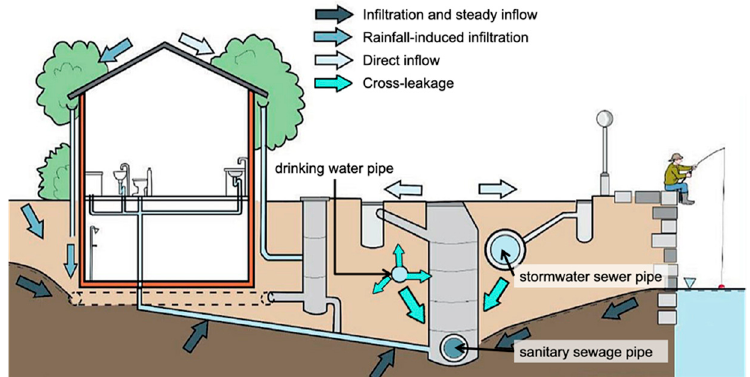
Figure 1. Possible sources of infiltration and inflow (modified from [10]).